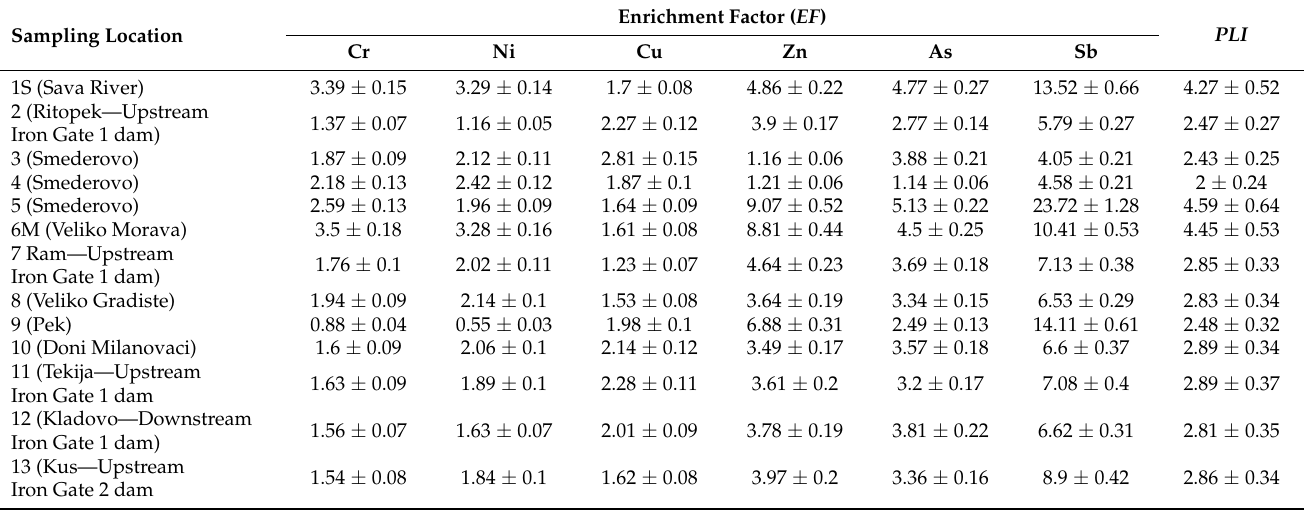
Table A1. The distribution of EF as well as of the corresponding PLI [44] of investigated PCE (Cr, Ni, Cu, Zn, As, and